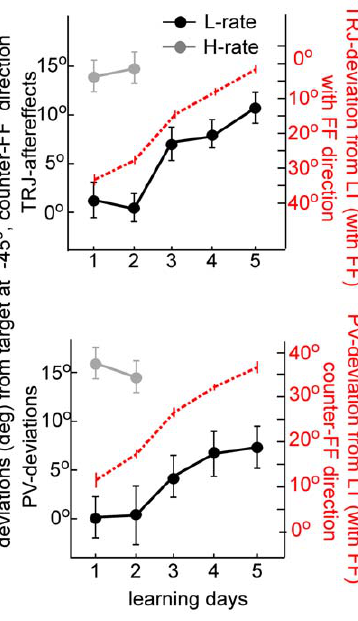
Figure 8. The generalization effect in movements to the target at 2 45 6 is correlated with adaptation. The developments of TRJ- aftereffects (upper plot) and PV-deviations (lower plot) from the target at 2 45 u along learning days. Deviations were significant in the later days of the L-rate (black) learning set and in both days of H-rate (grey). Note that the gradual development along L-rate was closely related to the decreased deviations in movement to the learned target (dashed red line, upper plot) and to the increased deviations of the corresponding PVs (dashed red line, lower plot). number of cells = 851. Error bars denote